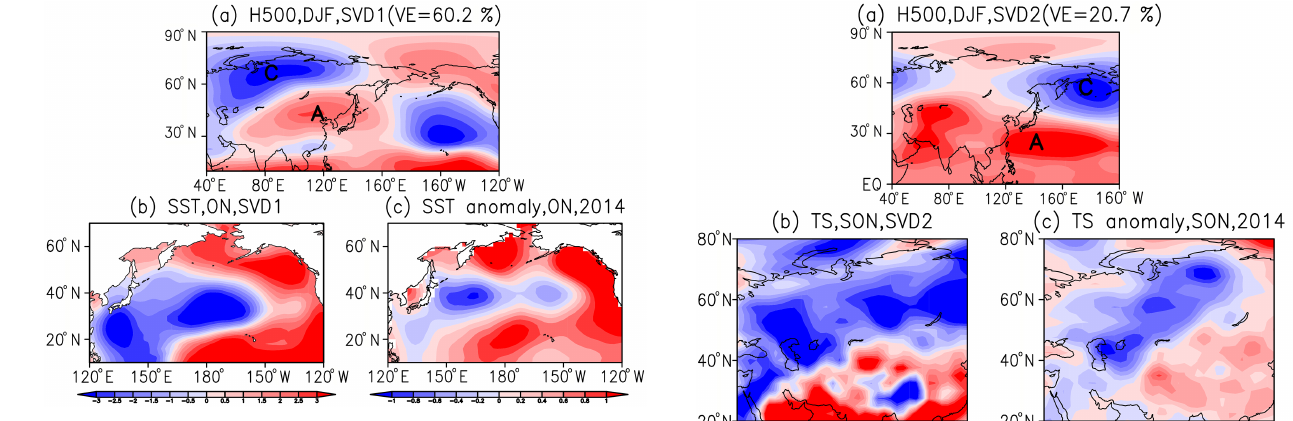
Figure 9. Heterogeneous correlation map of the first SVD mode for detrended and normalized (a) H 500 during DJF and (b) SST during ON 1979–2014, as well as (c) the SST anomalies during ON 2014. Letters A and C in panel (a) represent anticyclone and cyclone, respectively.